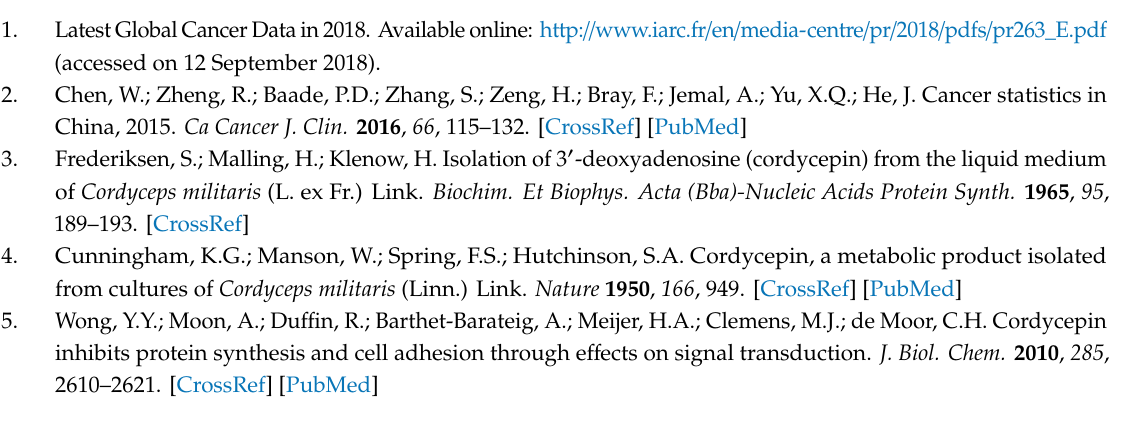
Table S2: Anti-tumor potential of COR, Table S3: Anti-inflammatory and anti-oxidant potential of COR, Table S4: COR inhibiting polyadenylation of mRNA in pathogens, Table S5: Other medicinal value and biotechnological